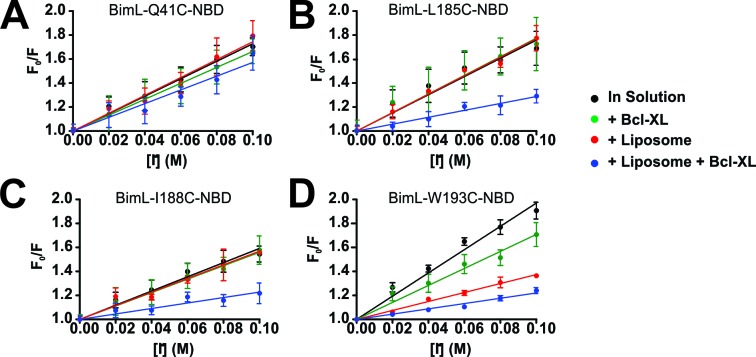
Residues in the Bim CTS are protected from iodide when bound to membranes and Bcl-XL.(A–D) Representative Stern-Volmer quenching plots for specific residues in Bim. The fluorescence of BimL mutants labeled on the single cysteine with NBD (indicated at the top of each panel) was recorded before (F0) and after (F) incubation with the indicated concentration of iodide. F0/F was plotted against iodide concentration to generate Stern-Volmer quenching plots; error bars, STDEV, n > 3. Stern-Volmer constants (KSV) calculated as the slope of the line of linear best fit for Bim in solution (black) were compared to values for KSV for incubations containing Bim and Bcl-XL (green), Bim and liposomes (red) and Bim, liposomes and Bcl-XL (blue). The plots selected show: (A) the aqueous control Bim Q41C; (B) a residue protected primarily by interaction with the liposome membrane independent from Bcl-XL, Bim W193C; (C–D) two residues protected only when both liposomes and Bcl-XL were added, Bim-L185C and Bim-I188C (to facilitate comparison with other figures the numbering was increased by 56 residues so that the numbers correspond to positions in BimEL).10.7554/eLife.37689.036Figure 9—figure supplement 1—source data 1.Source data for Stern-Volmer quwnching plots for representative mutants of Bim.